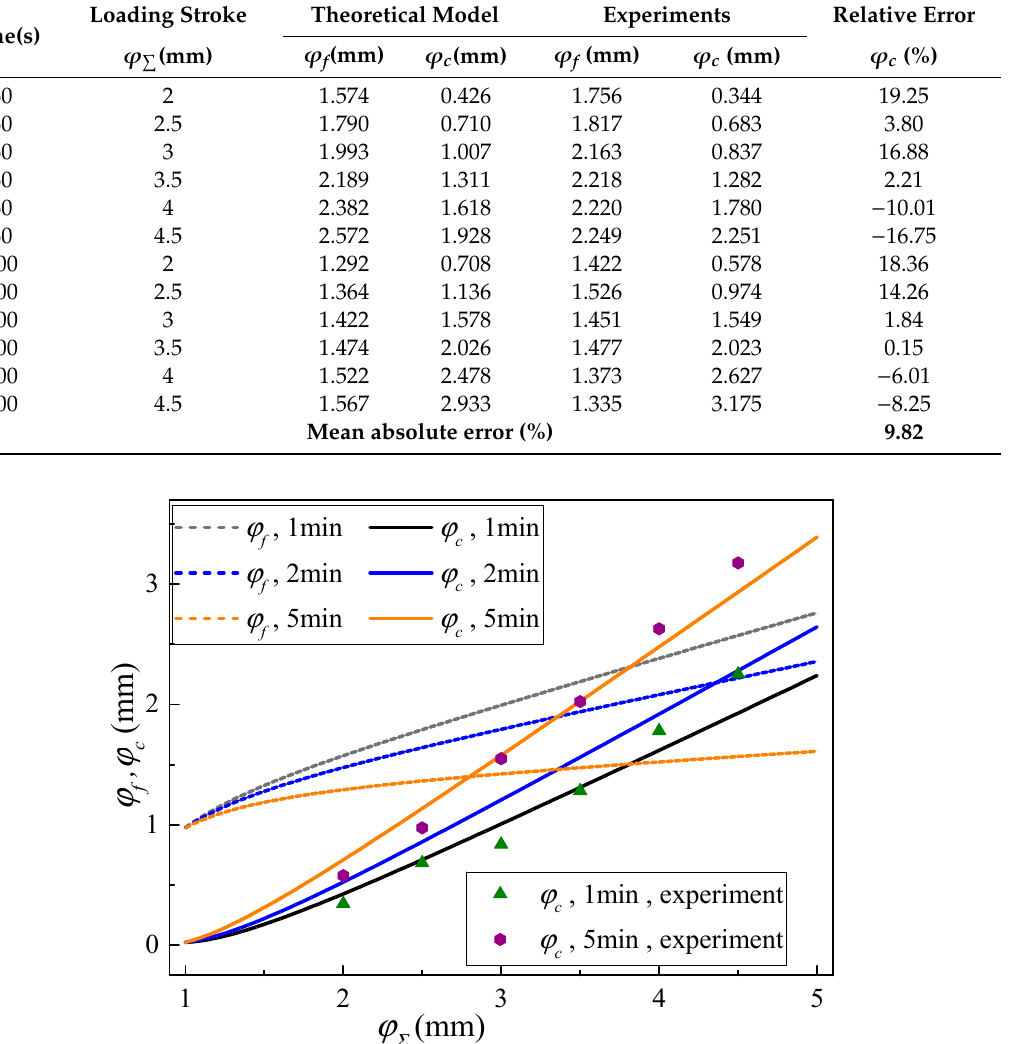
Table 4. Experimental results of springback.